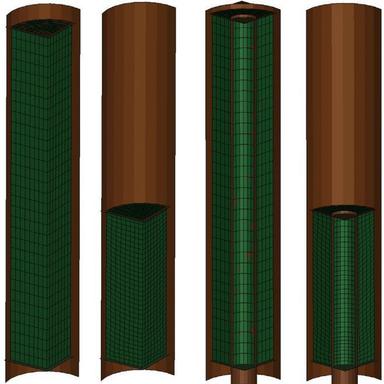
FE-mesh before and after compaction. The mesh to the left is used for reverse engineering and the mesh to the right is used to validate current results. Two symmetry planes are applied. Powder in green and pressing tool in brown.